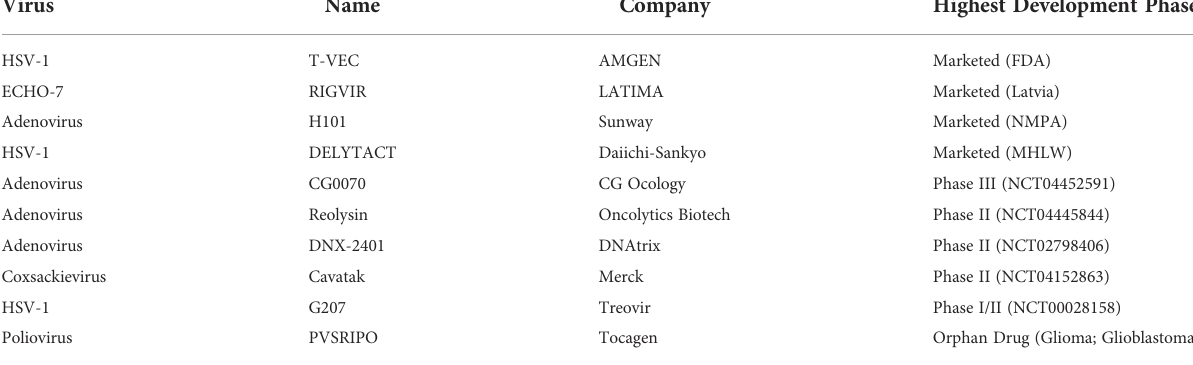
TABLE 4 Summary of marketed and clinically reported oncolytic virus (Up to April 2022).